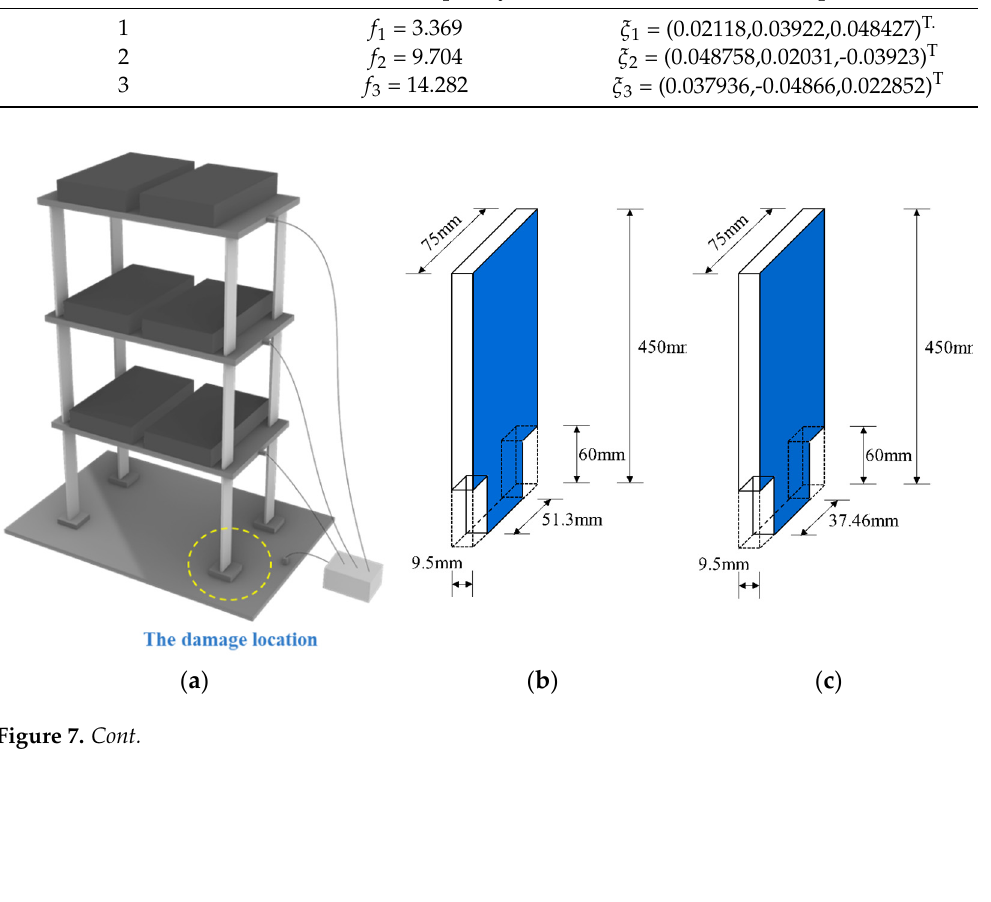
Table 6. Experimental modal data for the undamaged structure. Mode Number Natural